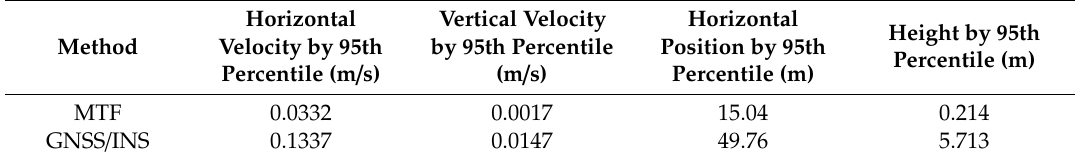
Figure 10. The position and velocity errors of the traditional GNSS/INS tightly coupled integration in the satellite outage case. Table 4. Comparison of statistical results generated by the proposed MTF method and conventional GNS / INS coupled integration in the satellite outage case (the 95th